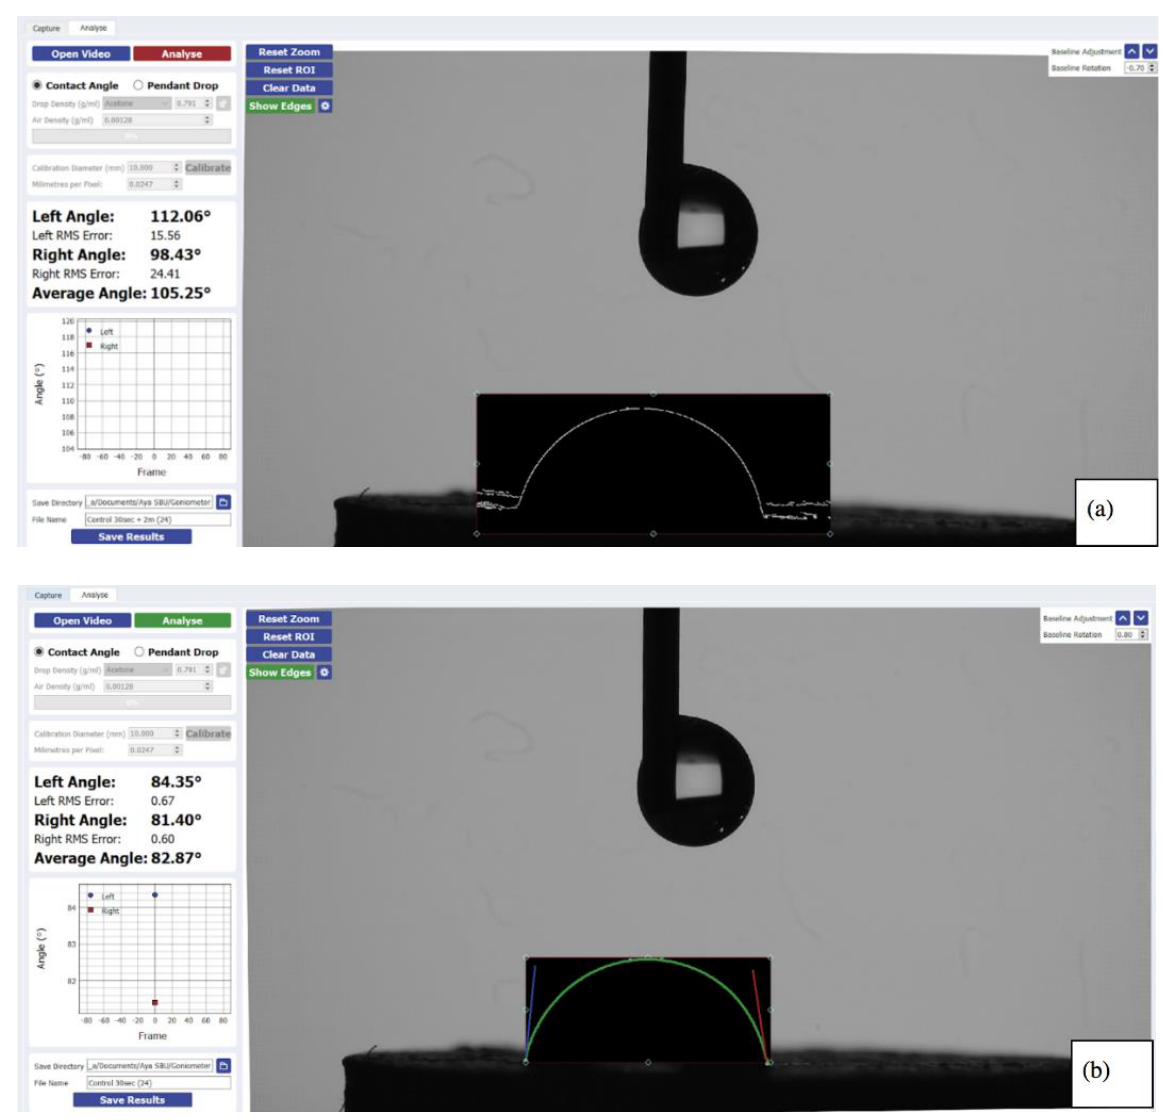
Figure 2. Processing of the drop’s right and left contact angles after recording the picture using Ossila Software v.3.1.2.2 (Ossila European Fulfilment, Sheffield, UK) showing the delineation of the drop